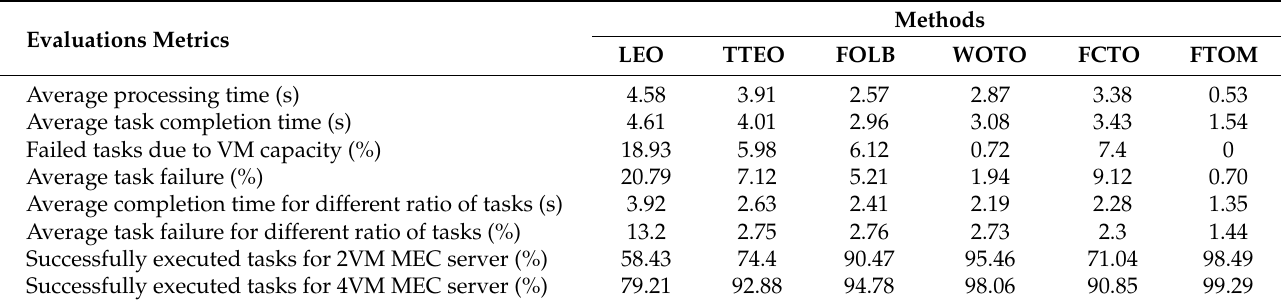
Table 8. Results summary of different